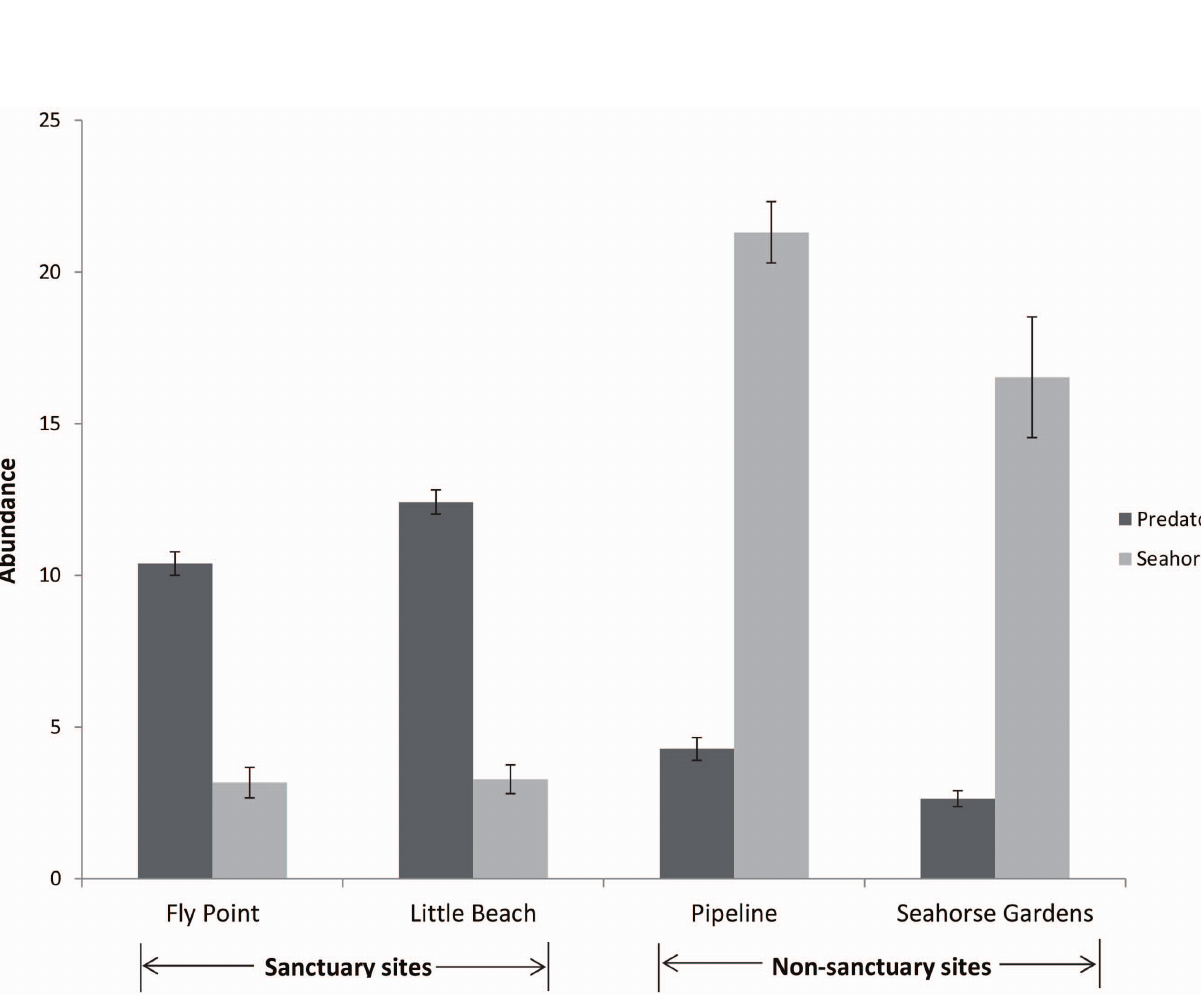
Figure 4. Monthly mean abundance ( ± S.E.) for H.whitei and predators (fish and octopus) for each site from 2007–2009. doi:10.1371/journal.pone.0105462.g004 PLOS ONE |